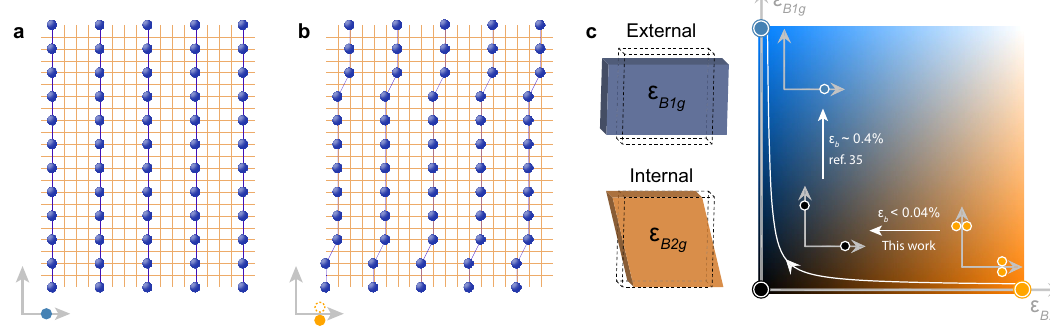
Fig. 4 Stripe order structures and strain phase diagram. a , b Schematic of half- fi lled, site-centred stripes. The orange grid represents the square CuO 2 lattice. Spheres illustrate the charge stripes. The in-between antiferromagnetic texture is not shown. a illustrates a statically pinned stripe order. Transverse kink ordering is illustrated in b . The density of aligned kinks along the stripes determines the transverse incommensurability δ ⊥ . For unstrained LSCO, the density is about one kink every 20 copper sites. A schematic of the corresponding diffraction pattern is shown in the bottom-left corner. A dashed open circle indicates the position of charge order peak from the stripe twin domain rotating to the opposite direction. c Stripe order phase diagram as a function of orthorhombic B 1 g and B 2 g strain. The colour code indicates the parameter space coordinates ( gh ⊥ / κ ⊥ , gh ∥ / κ ∥ ), where gh i with i = ∥ , ⊥ represent orthorhombic strain and κ i the stripe stiffness. Blue, black and orange phases represent pinned detwinned, pinned twinned and depinned twinned stripe order, respectively. White curve with arrow indicates schematically the connecting experiment trajectory upon application of uniaxial pressure. The straight white arrows indicate uniaxial pressure (this work and ref. 35 ) applied to connect the different stripe order structures. Schematics on the left-hand side illustrate the two types of orthorhombic lattice